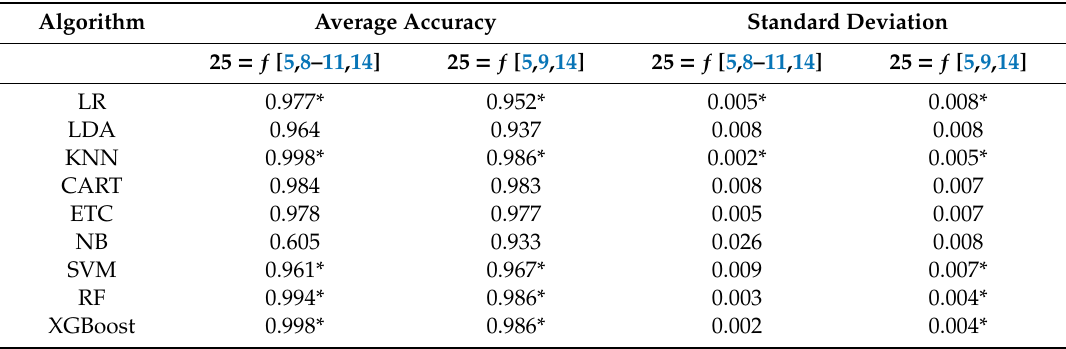
Table 13. Average accuracy—selected environmental and biometric data for plant configuration identification. With *: average accuracy defined considering the tuning of